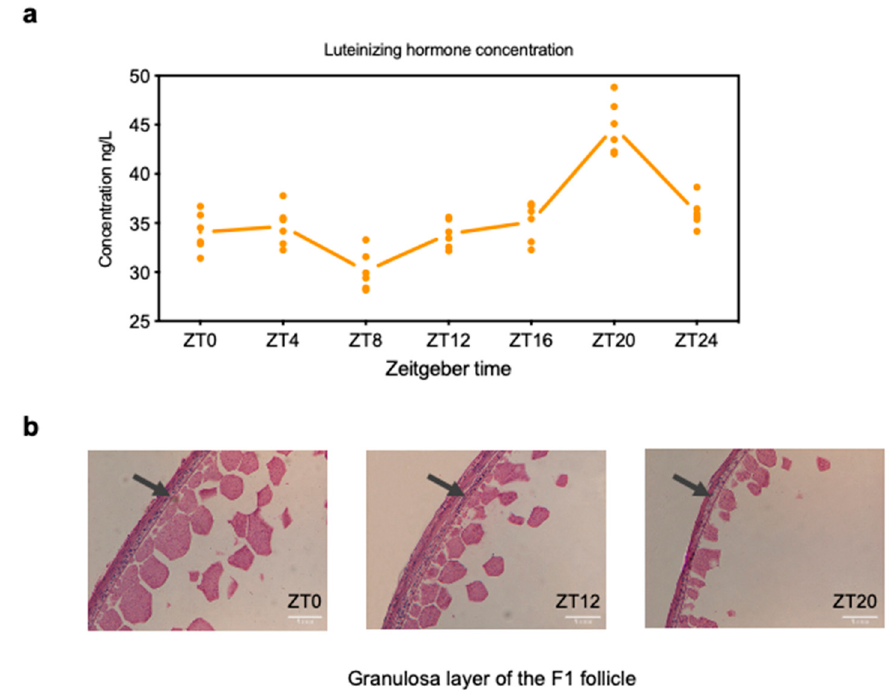
Figure 1. Changes in serum luteinizing hormone (LH) level and H&E-stained follicle granulosa layer among three stages of the ovulatory cycle. ( a ) LH concentration was measured in chicken serum during the ovulatory cycle (4-h intervals from ZT0 to ZT24 and six repetitions for each stage), and the highest LH level was detected at the ZT20 stage. ( b ) Chicken F1 follicles were embedded in paraffin and stained with hematoxylin and eosin (H&E) at ZT0, ZT12, and ZT20. ZT0 (9:00 a.m.), ZT12 (9:00 p.m.), and ZT20 (5:00 a.m.) represent the early, middle, and LH surge stages, respectively, of the ovulatory cycle. Table 1. Data summary of RNA-seq in granulosa cell of chickens. Samples